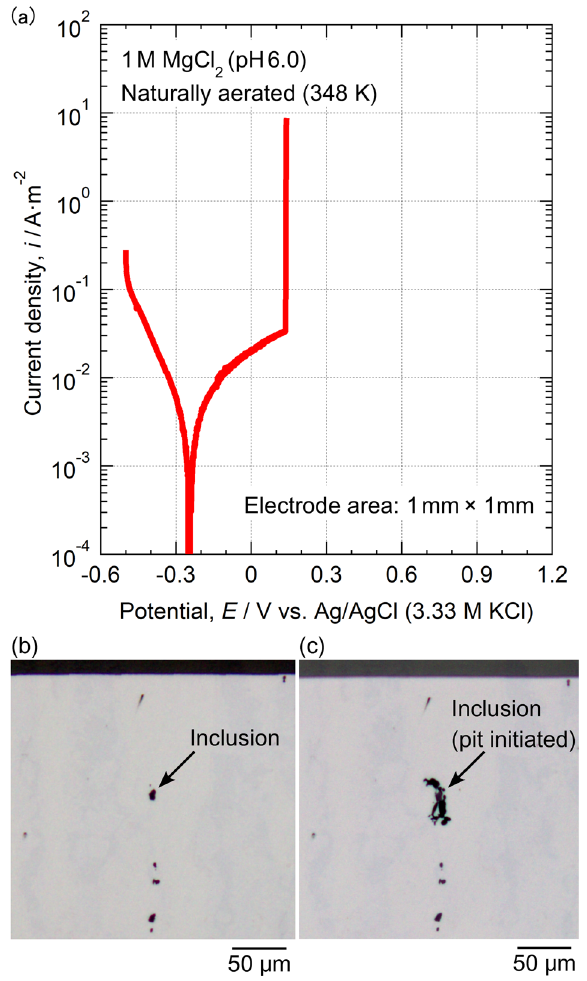
Fig. 11 Polarization behavior of a 1 × 1 mm electrode. a Polarization curve of a small area (1 × 1 mm) of the aged specimen with inclusions in naturally aerated 1 M MgCl 2 at pH 6.0 (348 K). b , c Optical micrographs of the pitting corrosion initiation site b before and c after